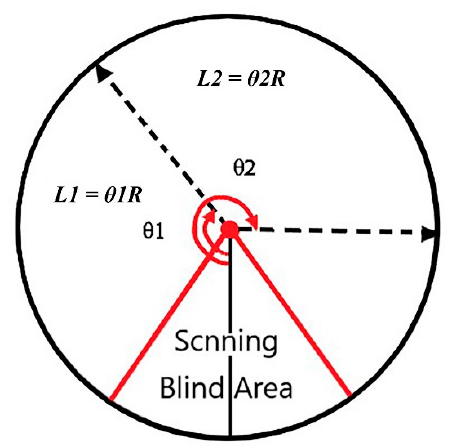
Figure 4. Schematic diagram of slice point cloud projection.